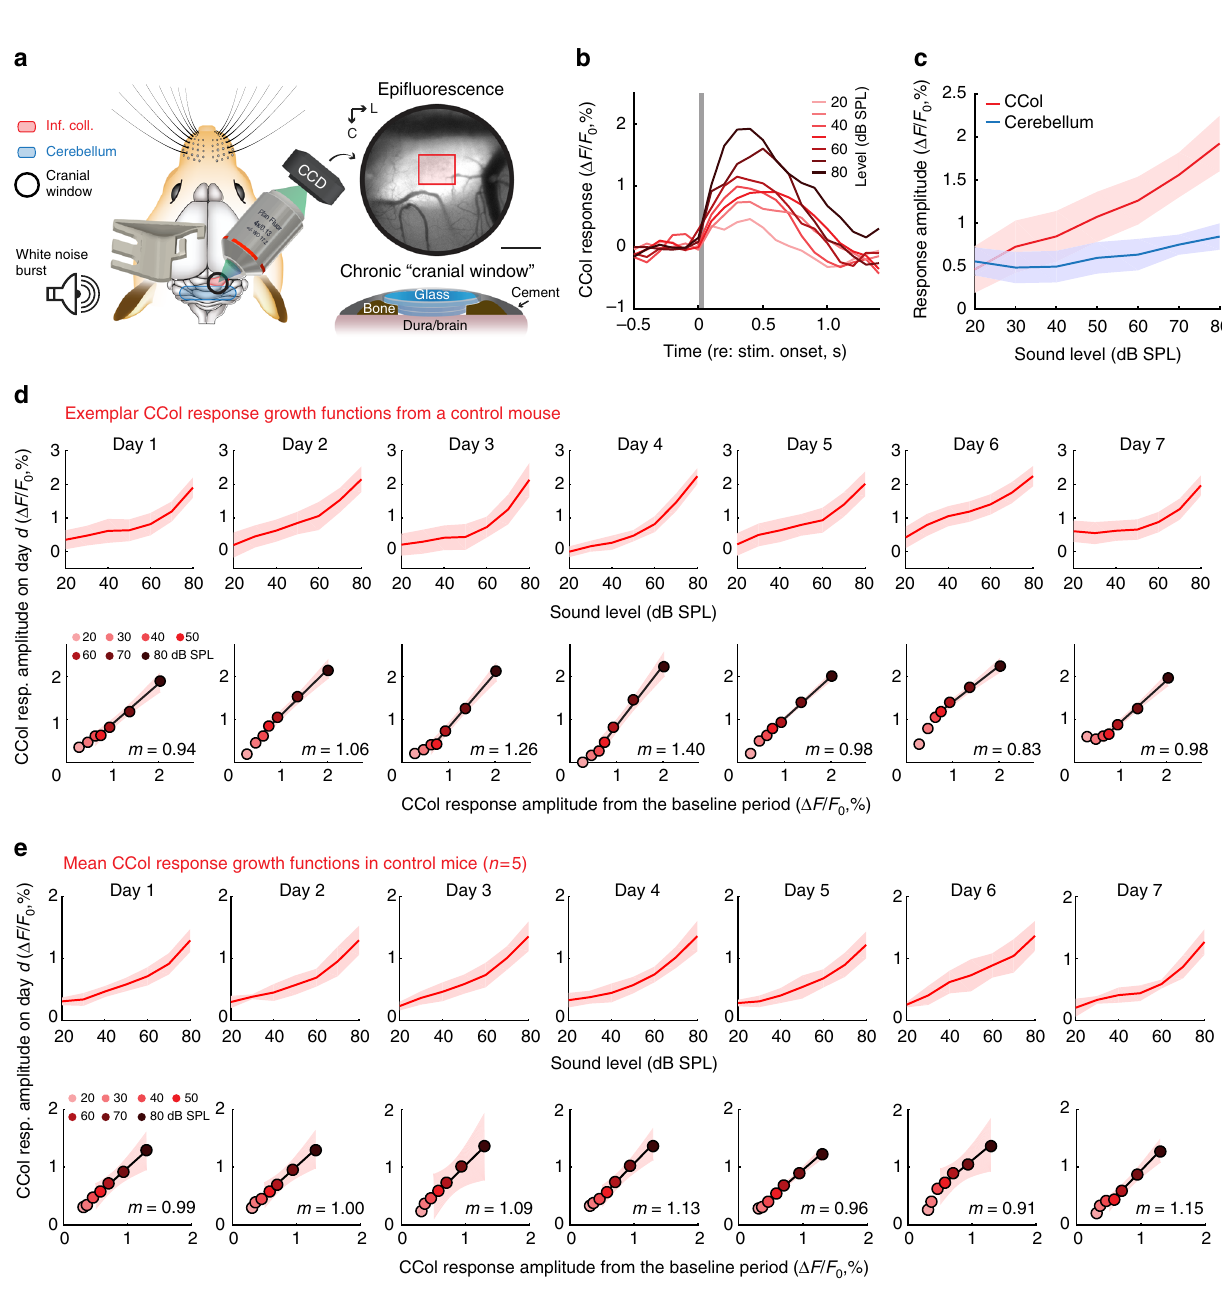
Fig. 2 Sound-evoked corticocollicular axon response increases monotonically with sound level and remains stable over 1 week of imaging. a A chronic preparation for epi fl uorescence imaging of GCaMP6s in CCol axons via a cranial window (scale bars = 0.5 mm) in awake, head- fi xed mice. Red rectangle denotes region of interest for CCol imaging. L is lateral and C is caudal. Mouse schematics in Figs. 2a, 3a, and 4a are adapted with permission from Aronoff et al., 2010 69 . All rights reserved. These images are not covered under the CC BY license for this article. Scienti fi c data and content are original. b Time course of mean fractional change in the CCol response amplitude evoked by a 50 ms white noise burst from a single imaging session. Gray box denotes stimulus timing and duration. c The monotonic growth of CCol peak response amplitude falls off steeply when the region of interest is shifted away from the IC. Data represent mean ± SEM. d Top: CCol response growth functions from a single mouse across seven daily imaging sessions. Data represent mean ± SEM. Bottom: Scatterplots depict the mean CCol response amplitude ( x- axis) at each sound level measured from the fi rst two imaging sessions (de fi ned as baseline) against the CCol response amplitude ( y- axis) measured on the day speci fi ed. The slope ( m ) of the linear fi t provides an estimate of daily changes in response gain, where m = 1 indicates a matched response growth relative to baseline, m < 1 indicates a divisive fl attening of the growth function and m > 1 indicates a multiplicative enhancement relative to baseline. Shading represents the 95% con fi dence interval of the fi t. e As per d , averaged across all control mice ( n = (repeated measures ANOVA, baseline vs day 1, F > 12, p < 0.005 ANOVA, baseline vs 2 weeks, F < 2.1, p > 0.05 for 8 – 16 kHz; F > 9, for 11.3 – 32 kHz tones; Fig. 3d gray vs orange). When measured p < 0.005 for 22.6 and 32 kHz, Fig. 3d, gray vs red). To con fi rm again 2 weeks after noise exposure, a full recovery was observed at that reduced ABR wave 1 amplitude was associated with a loss of low- and mid-frequencies, yet wave 1 amplitude remained cochlear afferent synapses, we quanti fi ed immunolabeling of signi fi cantly reduced at 22.6 and 32 kHz (repeated measures auditory nerve synapses onto inner hair cells in the high-